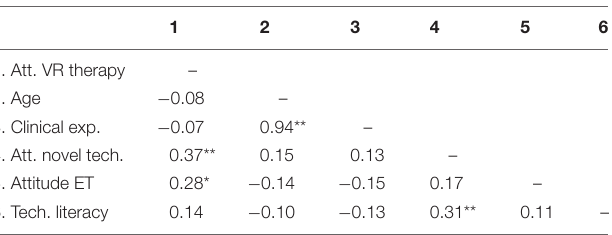
TABLE 2 | Pearson’s correlation coefficients of the study variables for the clinician sample.